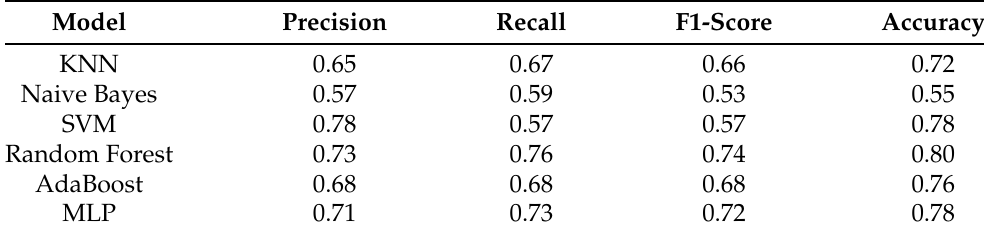
Table 6. Classification Results Features